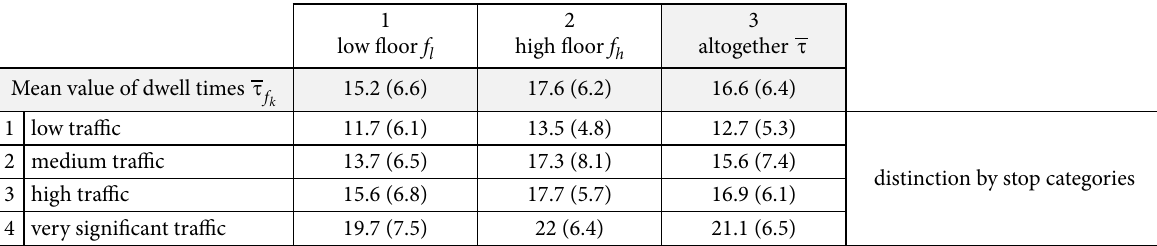
Table 7. Mean values and standard deviation of dwell times [s] at stops according to floor height and stop categories ( source : research by the authors) 1